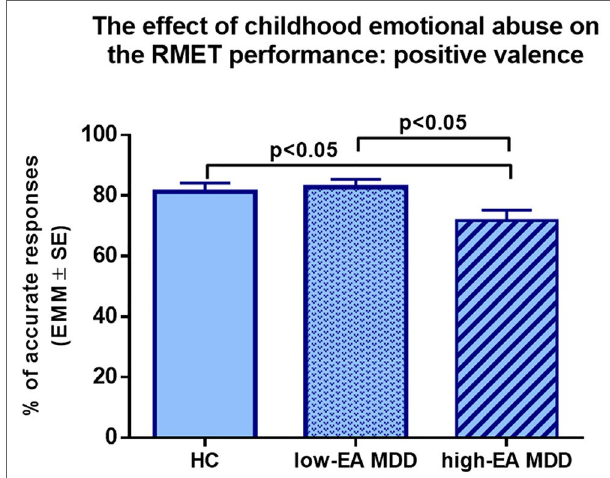
FIgURe 4 | Results of one-way ANCOVA with age, sex, and years of education as covariates. Estimated marginal means (EMM) are presented. MDD patients with moderate or severe childhood emotional abuse performed significantly worse in the positive valence compared to healthy controls and MDD patients without moderate or severe emotional abuse. EA: Emotional Abuse, HC: healthy control group, Low-EA MDD: a subgroup of MDD patients without moderate or severe childhood emotional abuse, High-EA MDD: a subgroup of MDD patients with moderate or severe childhood emotional abuse.